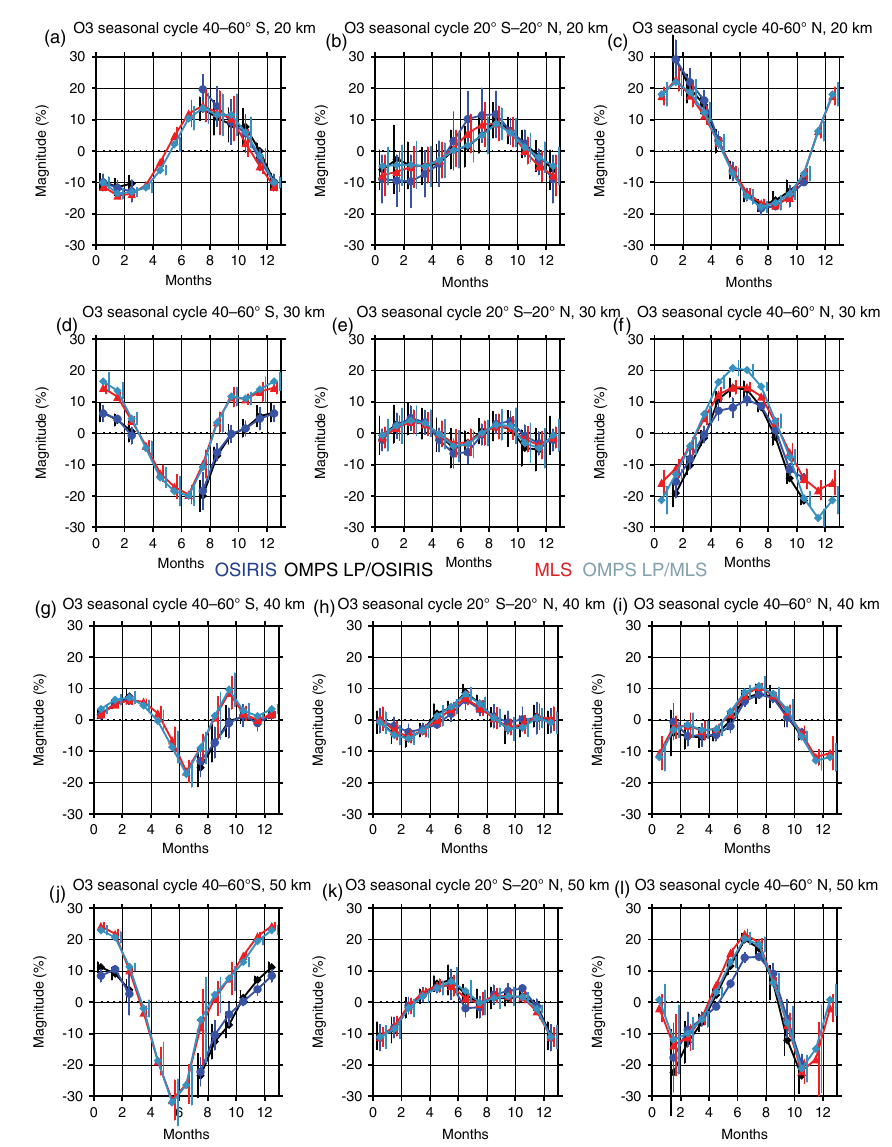
Figure 13. Seasonal ozone cycle (in % from the instrumental mean) for OMPS LP, MLS and OSIRIS in three wide latitude bins: 40–60 ◦ S (left column), 20 ◦ S–20 ◦ N (center column) and 40–60 ◦ N (right column). The seasonal cycle is shown at several altitude levels: 20.5km (a– c) , 30.5km (d–f) , 40.5km (g–i) and 50.5km (j–l) . OMPS LP seasonal values are calculated from both sub-samples: from matches with MLS (grey lines) and matches with OSIRIS (black). MLS seasonal values are shown in red and OSIRIS in blue. The standard errors of the mean are typically smaller than the width of the lines. The error bars indicate 1 σ standard